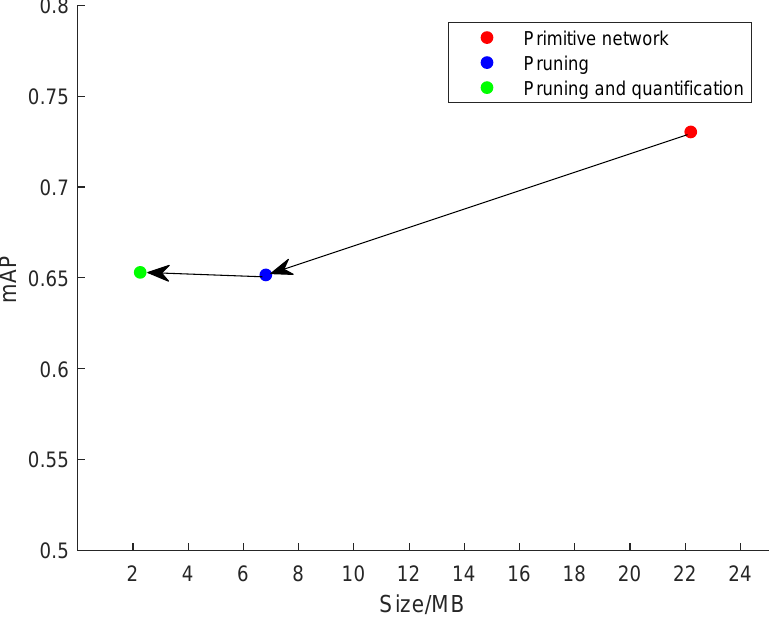
Figure 15. Changes in volume and accuracy of the